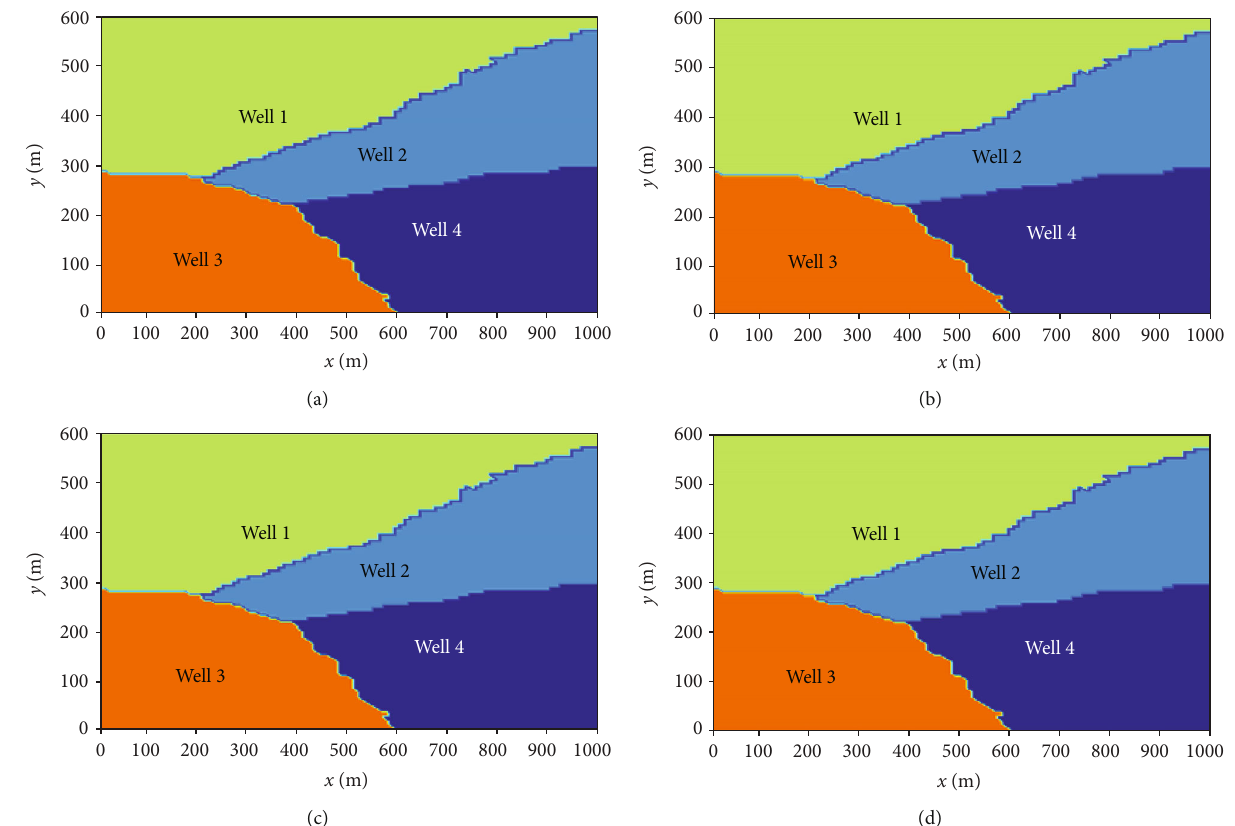
Figure 17: Geometries of the control volumes with di ff erent fracture conductivities: (a) 1 md · m, (b) 10md · m, (c) 100md · m, and (d) 1000md · m.